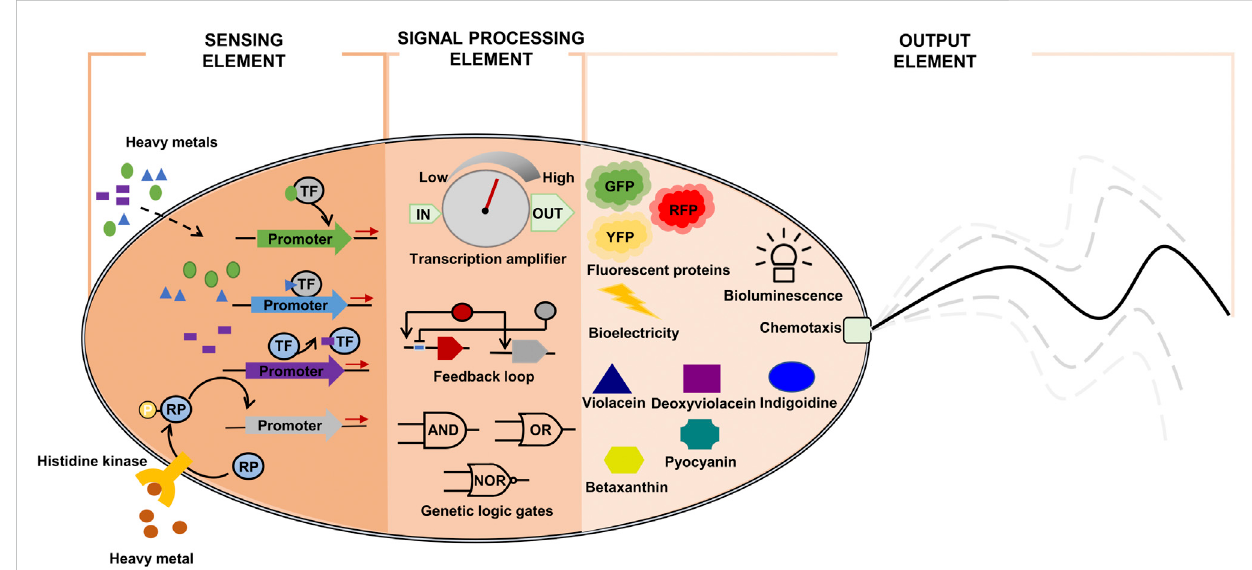
FIGURE 2 Components of synthetic bioremediation bacteria for heavy metal detection. GFP: green fl uorescent protein; RFP: red fl uorescent protein; RP: regulatory protein; TF: heavy metal-responsive transcription factor; YFP: yellow fl uorescent